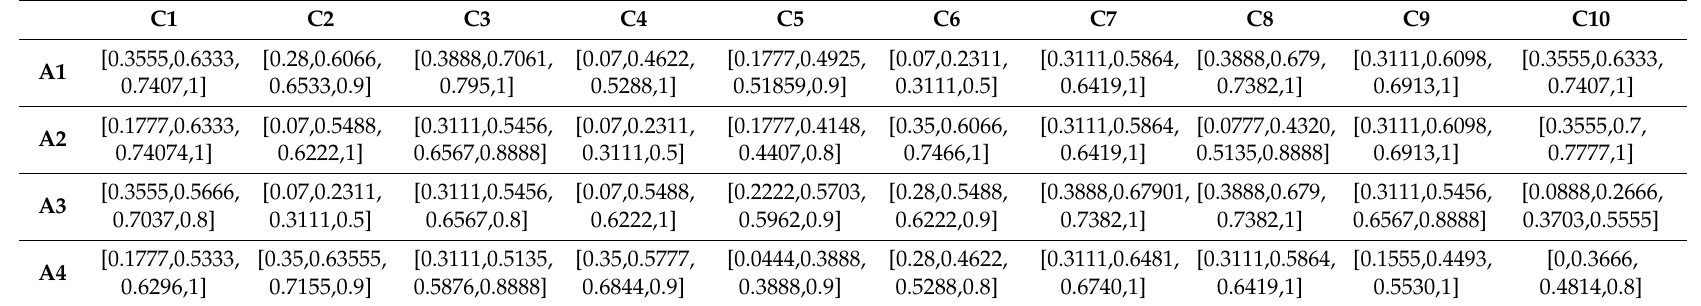
Table 10. Weighted normalized fuzzy decision